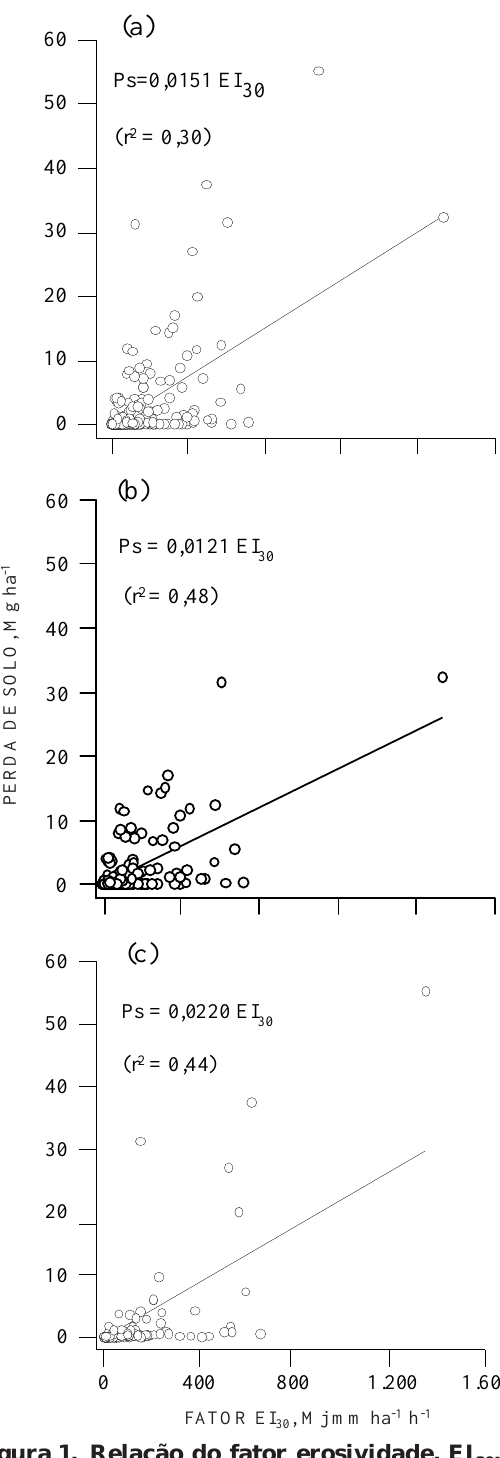
Figura 1. Relação do fator erosividade, EI as perdas de solo, Ps, (a) anual, com 437 eventos de erosividade e 339 dados de perda de solo; (b) primavera-verão, com 215 eventos de erosividade e 172 dados de perda de solo, e (c) outono-inverno, com 222 eventos de erosividade e 166 dados de perda de solo, para um Cambissolo Húmico alumínico léptico em Lages (SC), no período de 1989 a